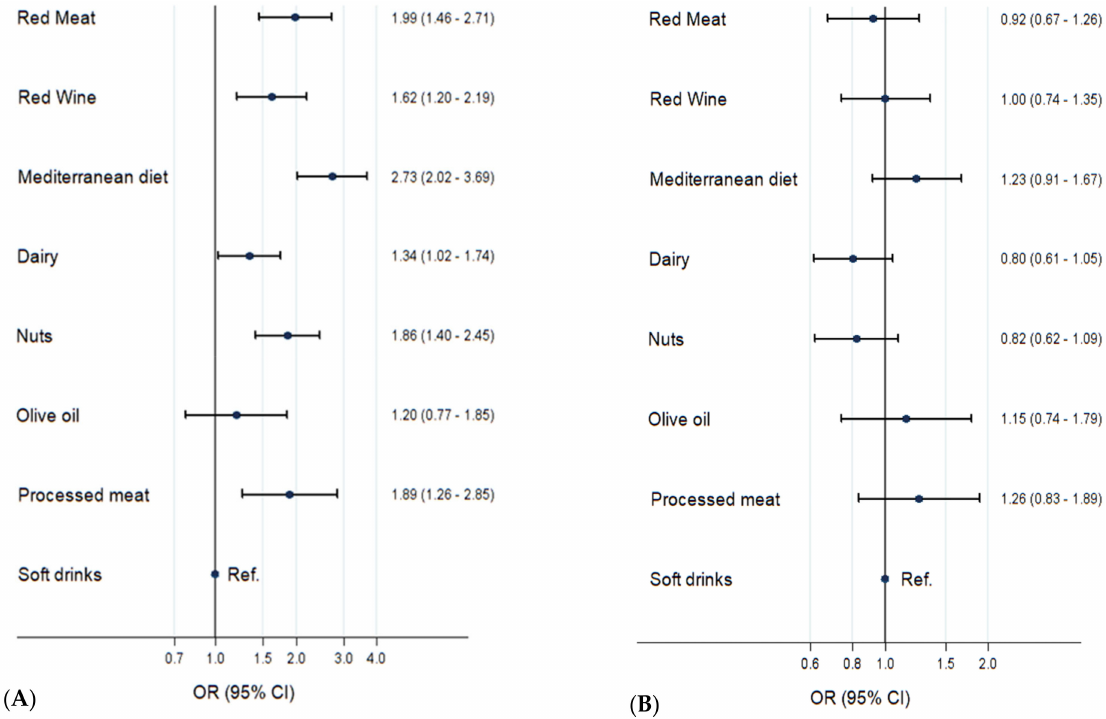
Figure 3. ORs and 95% CI for liking ( A ) and retweeting ( B ) a tweet related to the specific food groups of the study. The forest plots represent the different relative odds of a tweet sent by the selected US media outlets to be liked ( A ) and retweeted ( B ) compared to the soft drink group (reference